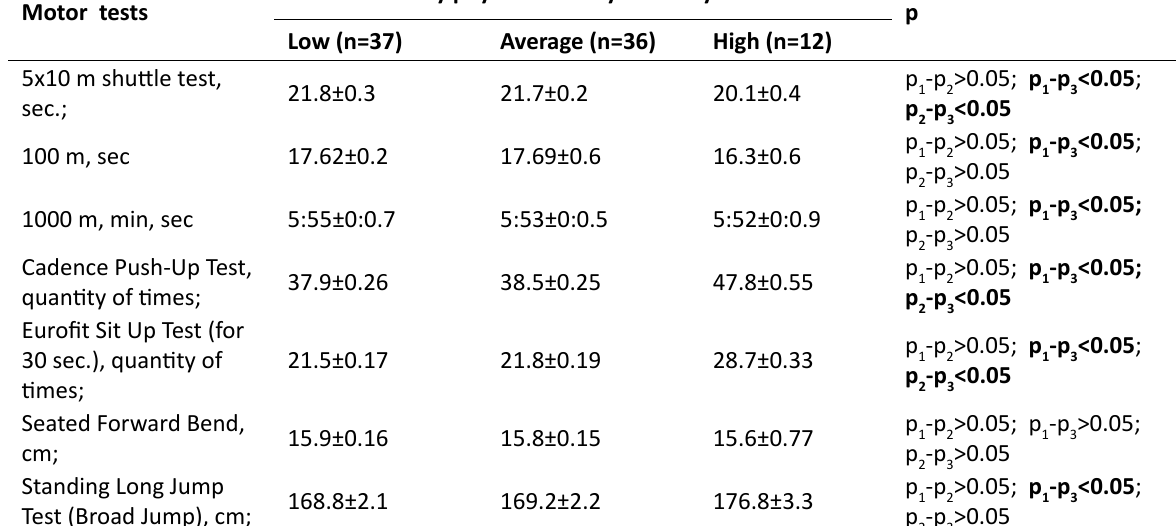
Table 5. The results of girls’ motor tests (M ± m) Level of weekly physical activity Motor tests